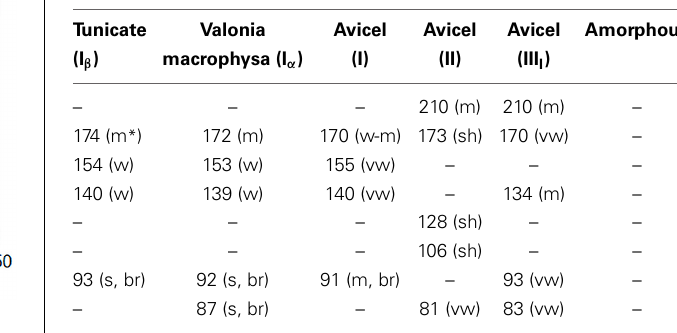
Table 4 | Raman peak positions in the low frequency region, cm − 1